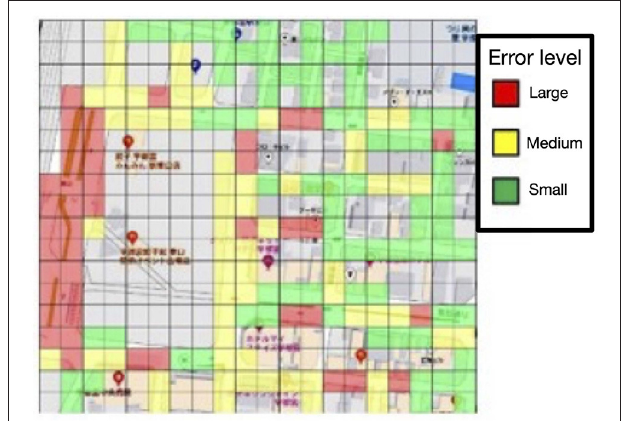
FIGURE 2 | An example of an error